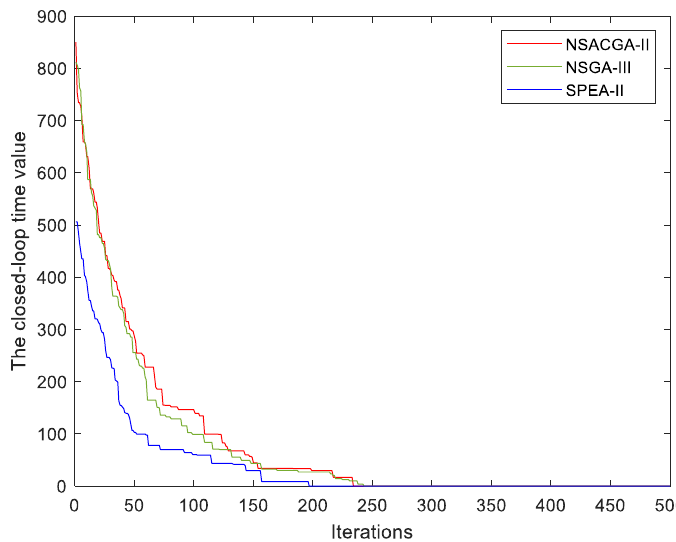
Figure 10. Convergence curves of NSACGA-II, SPEA-II and NSGA-III.